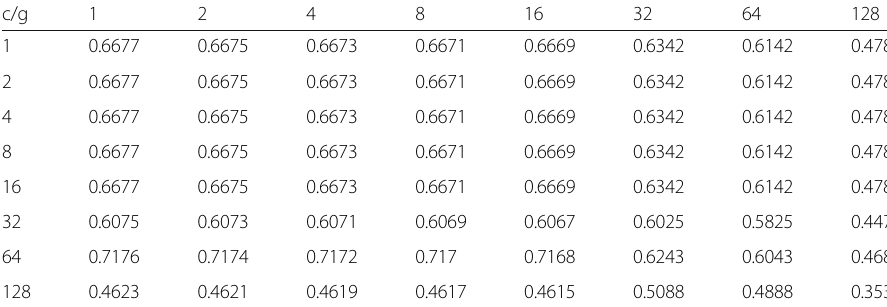
Table 3 DWSVM model mesh optimization algorithm _F value